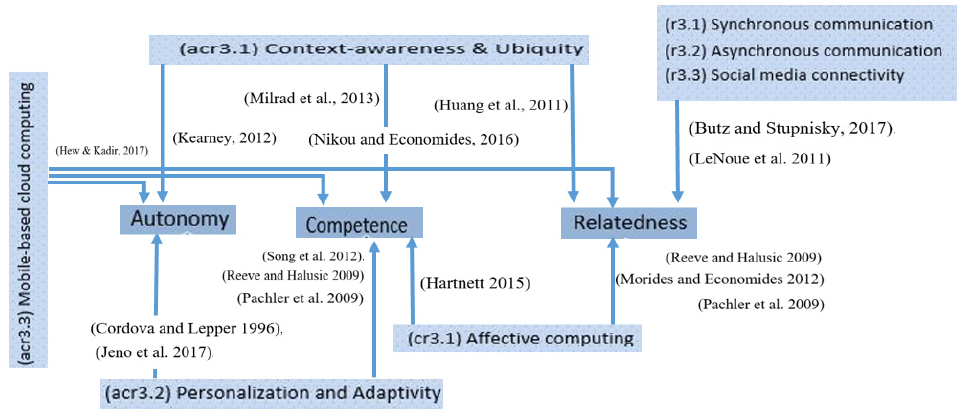
Figure 3. Motivation supportive mobile technologies.